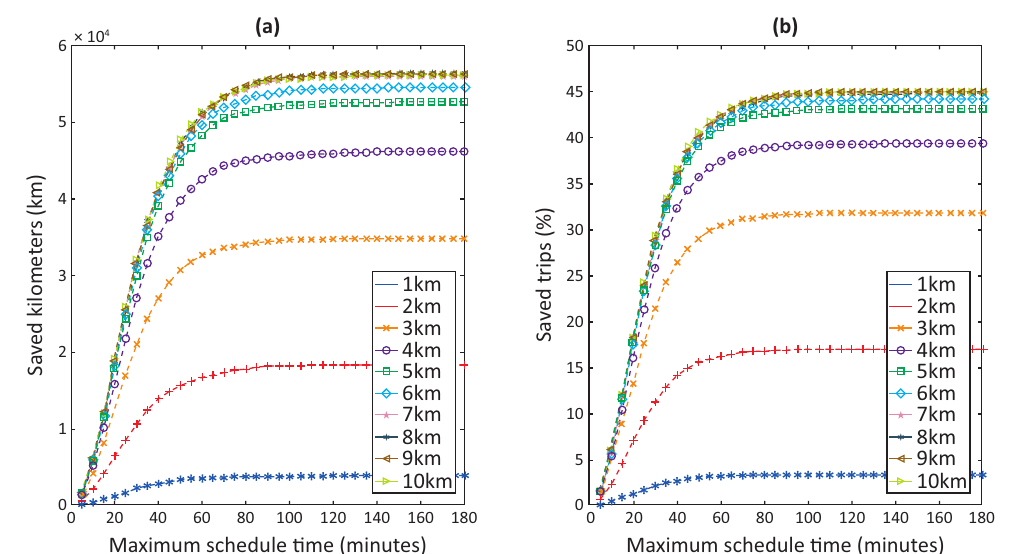
Figure 8. Effect of trip distance and maximum schedule time on (a) saved kilometers (b) number of saved trips.